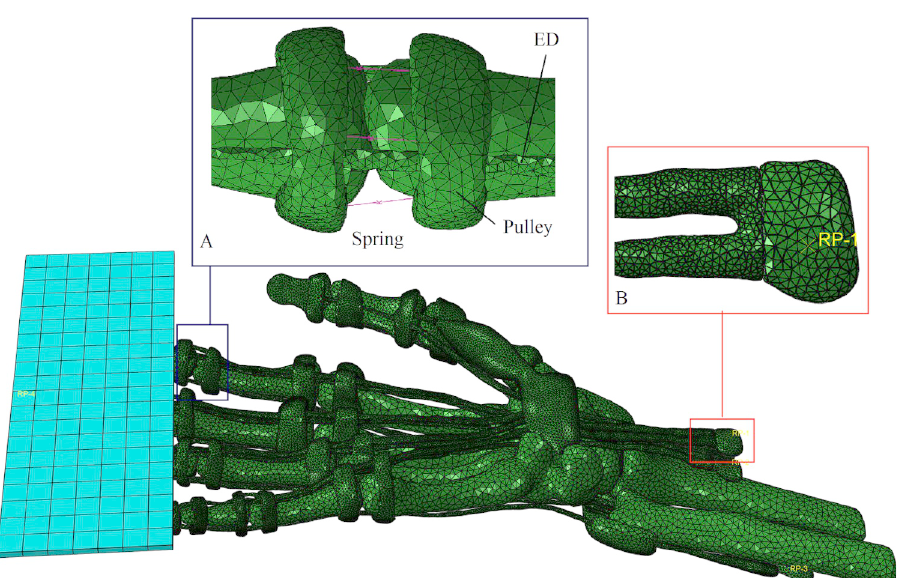
Fig 2. Loading conditions of flexion with resistance. (A) The joints were connected by three spring elements. ( B) The muscle connected to the tendon was defined as a rigid body.